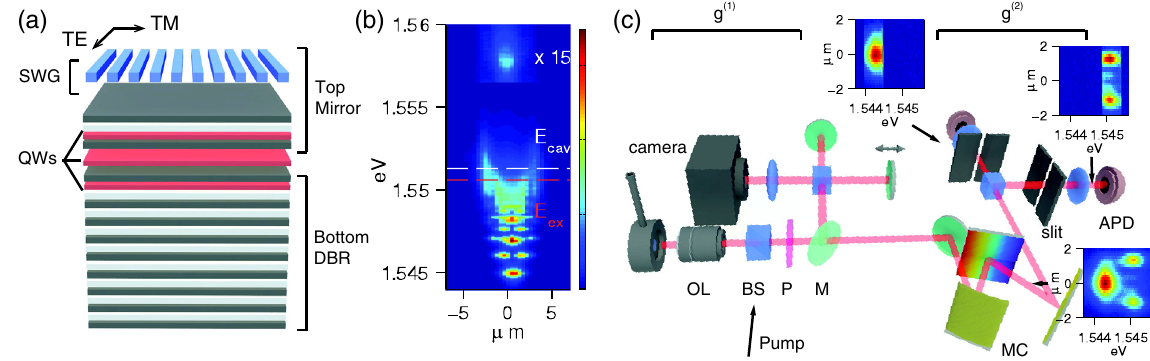
FIG. 1. The cavity system and experimental setup. (a) A schematic of the SWG-based microcavity. (b) The spectrally resolved real- space image of polariton states at a low excitation power. E is the cavity resonance, and E is the exciton resonance. E is estimated cav ex cav by using lower polariton, upper polariton, and exciton energies. (c) A schematic of the experimental setup. OL: objective lens; BS: beam splitter, P: polarizer; M: mirror; MC: monochromator; and APD: avalanche photodetector. For the g ð 2 Þ measurements, a monochromator followed by two mechanical slits was used to spectrally filter the discrete polariton states. Examples are shown for the spectrally resolved real-space images of the lowest two LP states right after the monochromator (bottom), the spectrally filtered ground state (top left), and the spectrally filtered first excited state (top right). The resolution of the spectral filter was about 0.08 nm, determined by the monochromator